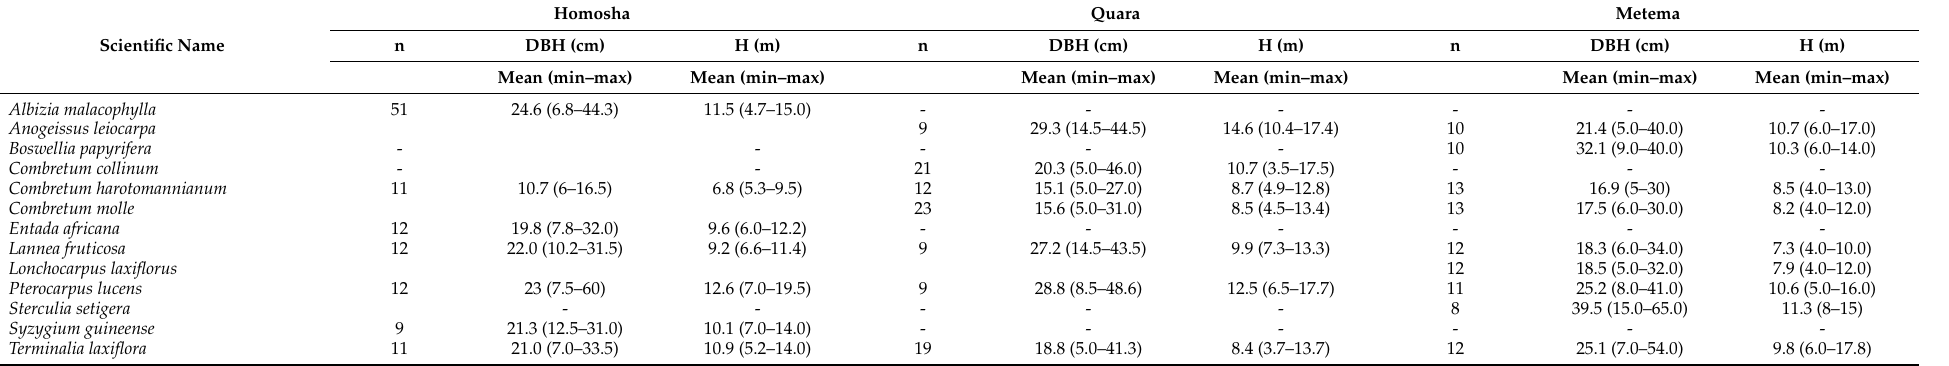
Table A1. The statistical summary of biometric variables such as diameter at breast height (D) and height (H) of the harvested tree species.